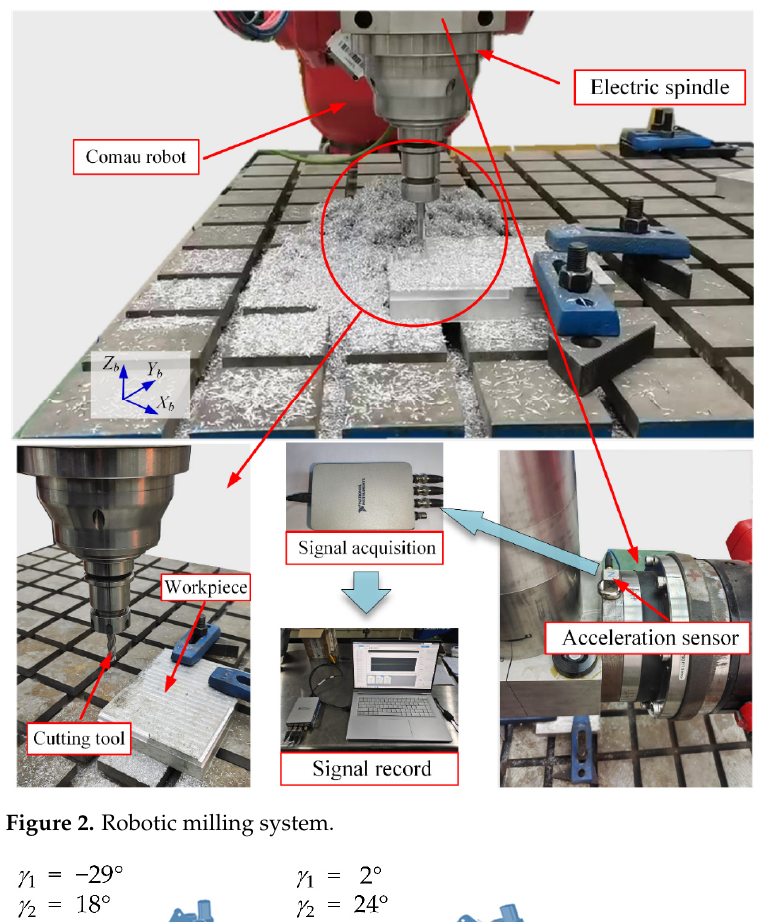
Figure 2. Robotic milling system.